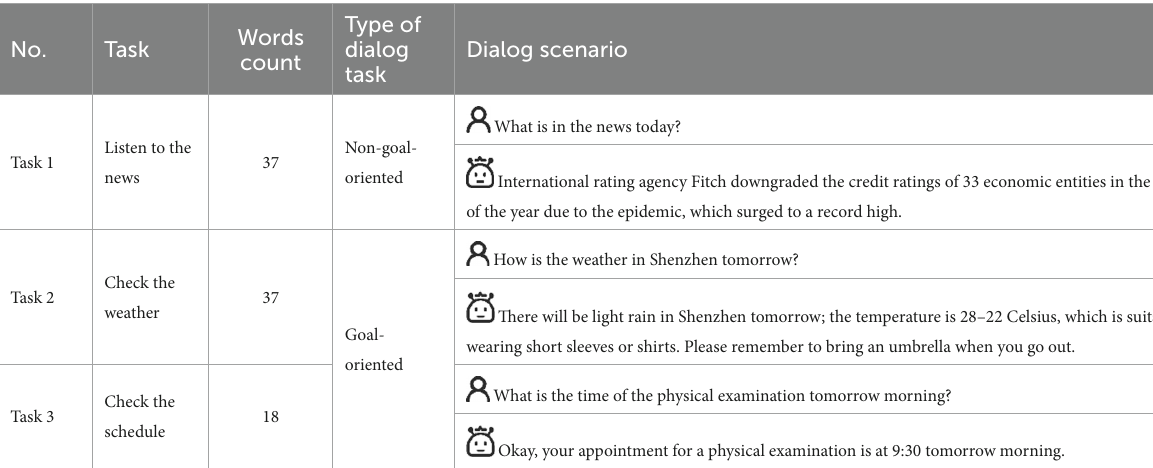
TABLE 2 Dialog task of voice interaction experiment.